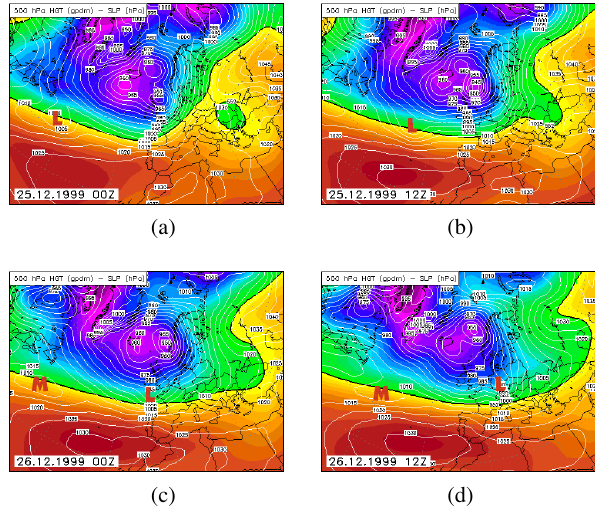
Figure 5. Section of the track of storm “Lothar” (the center is Figure 4. Section of the track of storm “Anatol” (the center is indi- the track of storm “Anatol” (the center is indicated by the letter A) in the sea level pressure field on 3 and Figure 5 : Section of the track of storm “Lothar” (the center is marked by the letter L) in the sea level pressure fields on 25 and Figure 4 : Section of marked by the letter L) in the sea level pressure fields on 25 and cated by the letter A) in the sea level pressure field on 3 and 4 De- 26 December, 1999 (white isolines. The track of storm “Martin” which followed right after “Lothar” has been marked with an 4 December, 1999 (white isolines). The 12-hour displacement of the center is marked by a red line in subfigure (b)–(d). The 26 December 1999 (white isolines. The track of storm “Martin” cember 1999 (white isolines). The 12-h displacement of the center M in subfigures (c) and (d). center’s positions found on 2 December 06z until 5 December 06Z are given in Tab. 2. which followed right after “Lothar” has been marked with an M in is marked by a red line in subfigure (b)–(d). The center’s positions